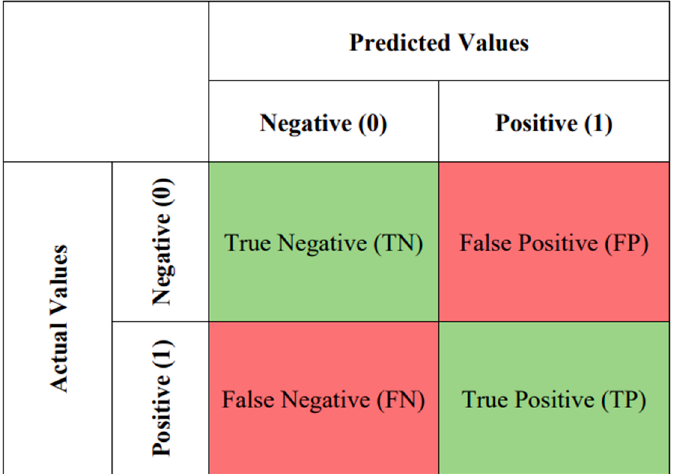
Figure 5. An example of a confusion